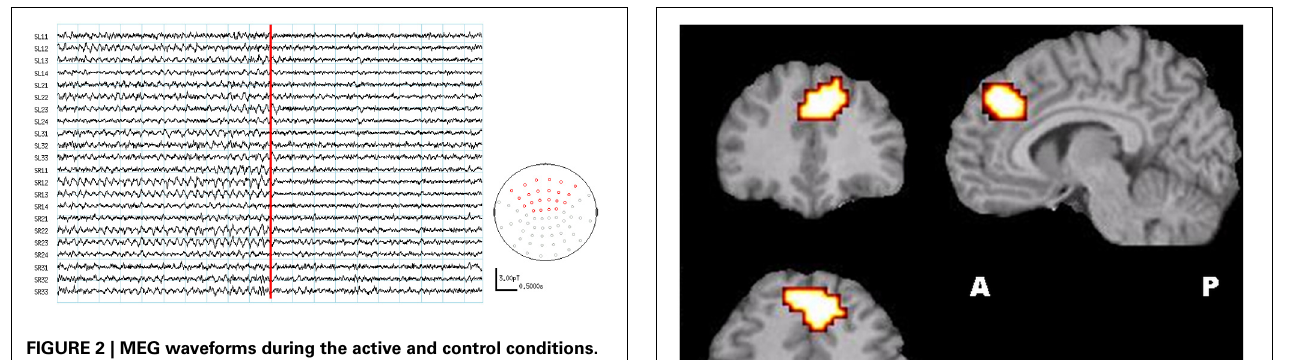
FIGURE 2 | MEG waveforms during the active and control conditions. The location of channels showing frontal theta enhancement are indicated in red color on the MEG sensor map.